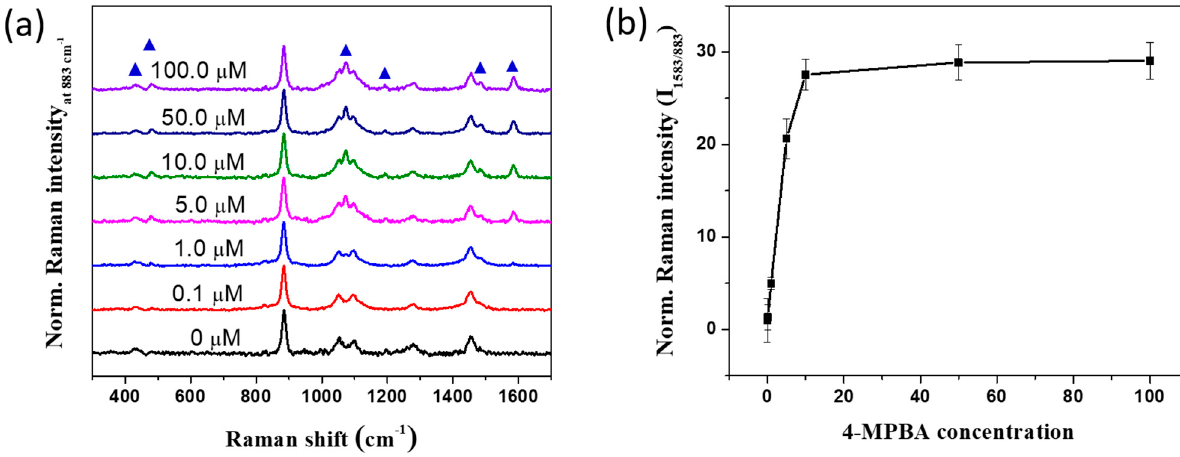
Figure 2. ( a ) SERS spectra and ( b ) normalized SERS intensity plot at 883 cm − 1 of SiO 2 @Au@Ag@4-MPBA at various con- centration from 0.1 to 100 µM in ethanol solution.